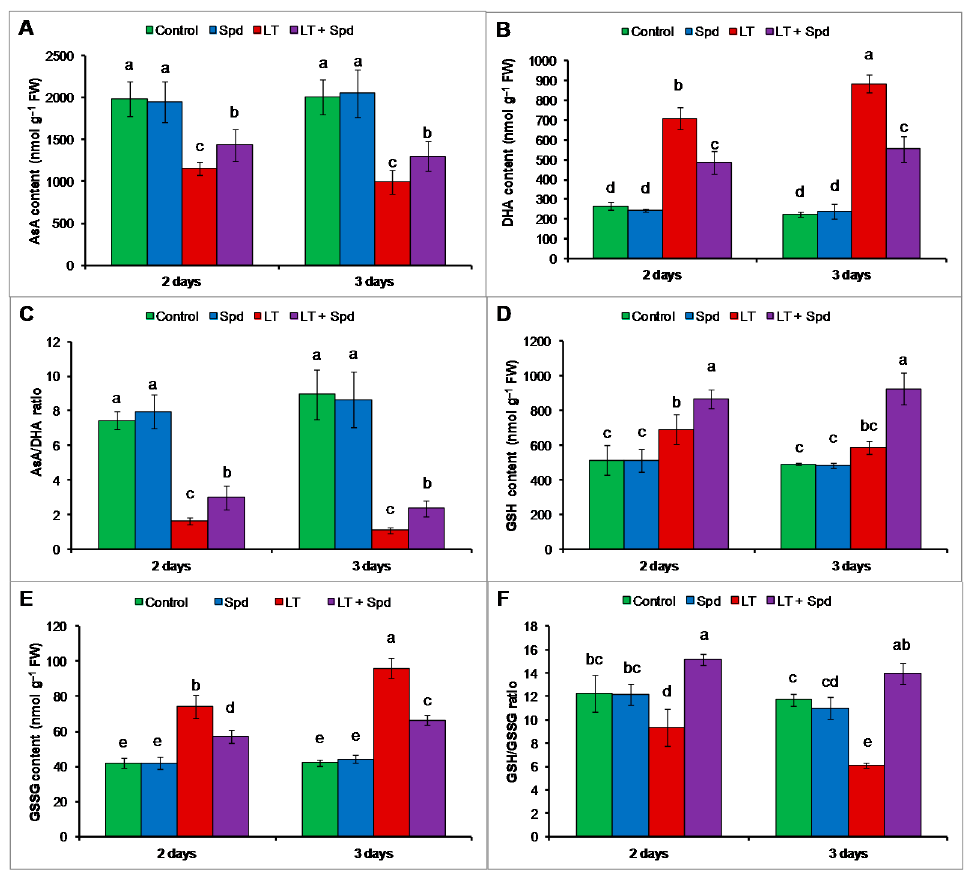
Figure 4. Ascorbate (AsA) ( A ) and dehydroascorbate (DHA) ( B ) contents, AsA/DHA ratio ( C ), glutathione (GSH) ( D ) and glutathione disulfide (GSSG) ( E ) contents, and GSH/GSSG ratio ( F ) in mung bean seedlings. Spd and LT indicate spermidine (0.25 mM) and low temperature (6 °C), respectively. Mean (±SD) was calculated from three replicates for each treatment. Bars with different letters are significantly different at p ≤ 0.05 applying DMRT.